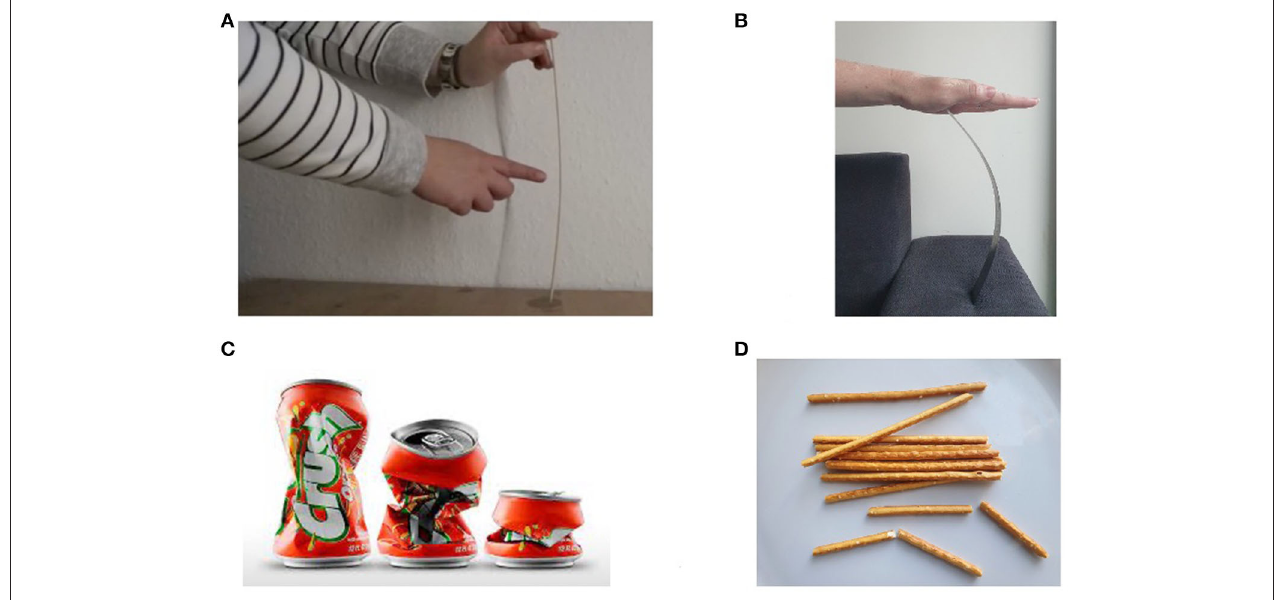
FIGURE 1 | (A–D) Paradigmatic meaning exists between choices: between “stable” choices such as a skewer and a ruler, and between the “stable” skewer/ruler, the “buckling” can and the “brittle” pretzel stick.